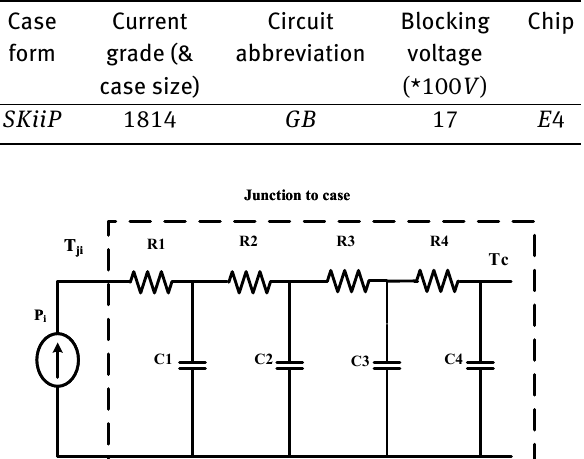
Figure 20: Mean temperature value T m extracted from the rainflow counting algorithm.